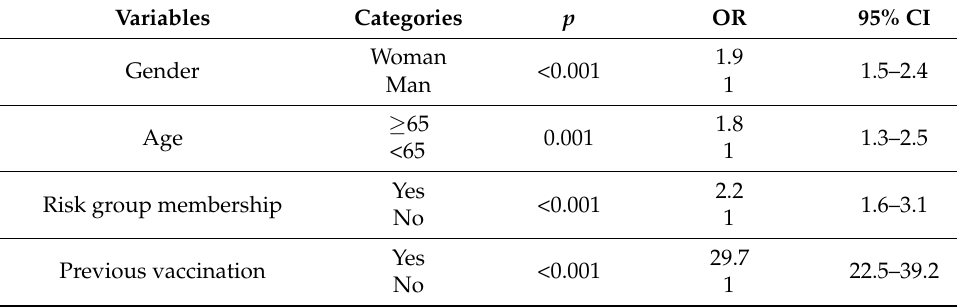
Table 6. Predictors of vaccination intention in the 2021/22